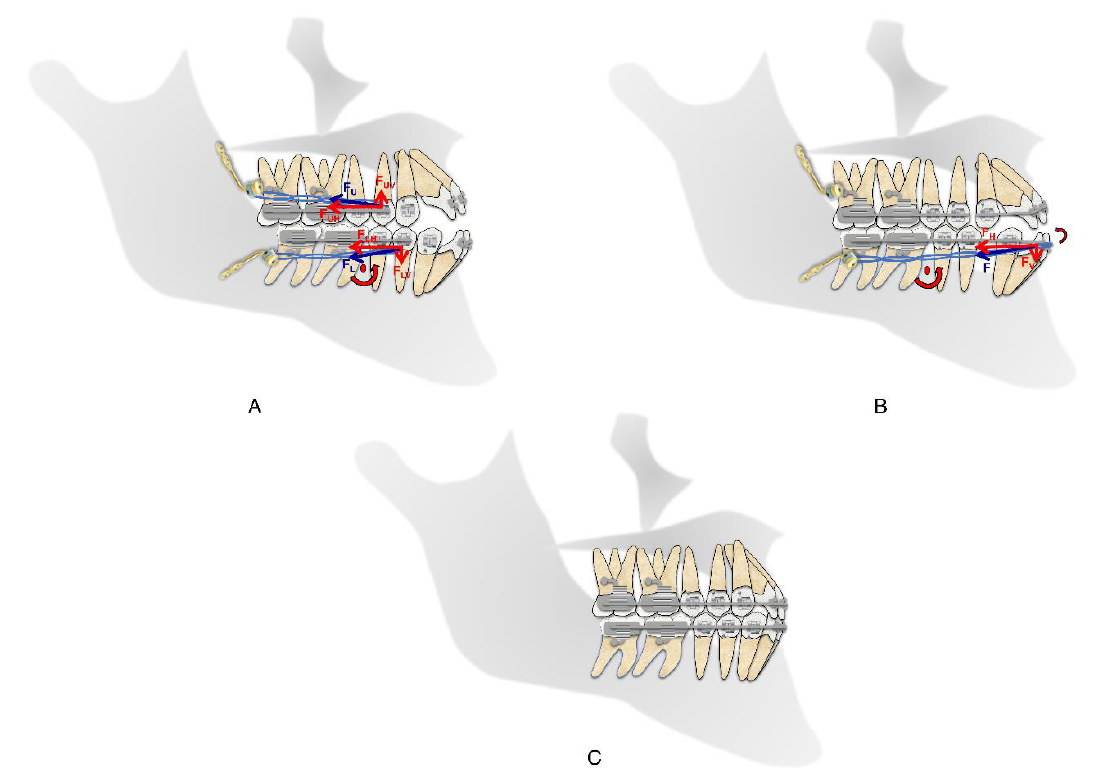
Figure 5. ( A )—The directions of the applied forces on this patient were backward and upward in the maxillary arch, and backward and downward in the mandibular arch. Thus, the intrusive component of applied forces might prevent the opening of the mandibular plane. ( B )—As the force vector is above the center of resistance of the mandibular dentition, the distalization forces lead to a counterclockwise rotation of the mandibular arch, thereby simultaneously decreasing the vertical dimension of the occlusion and the open bite. ( C ) — Final treatment result.